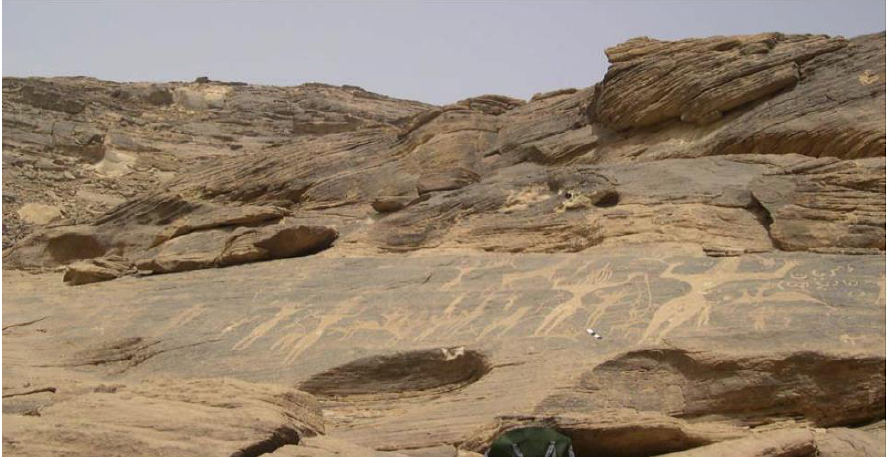
Figure 16. Several figures of “Alia” are located on a prominent higher and vertical surface of a